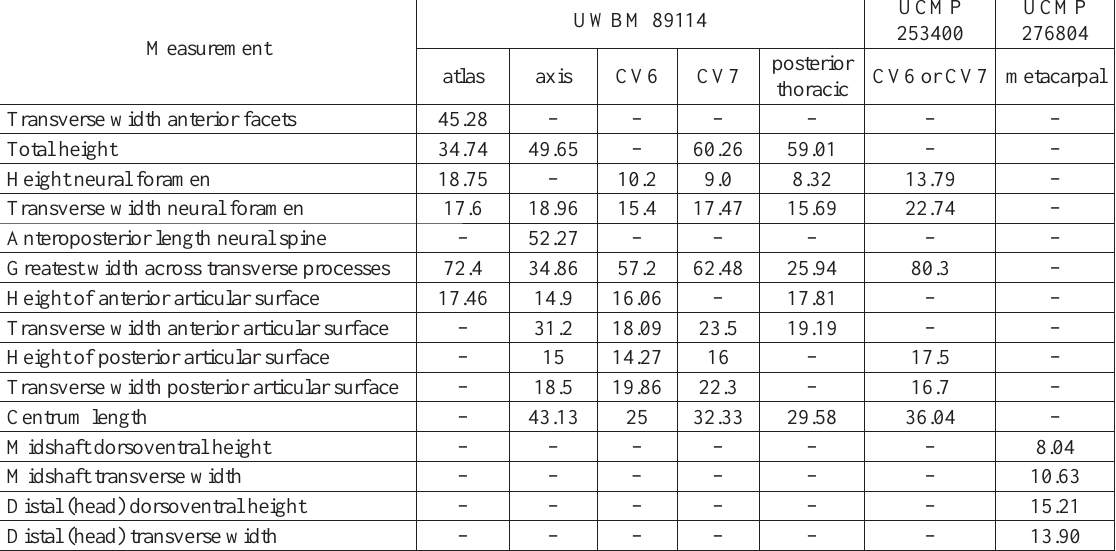
Table 2. Measurements (in mm) of Enaliarctos sp. postcrania. CV, cervical